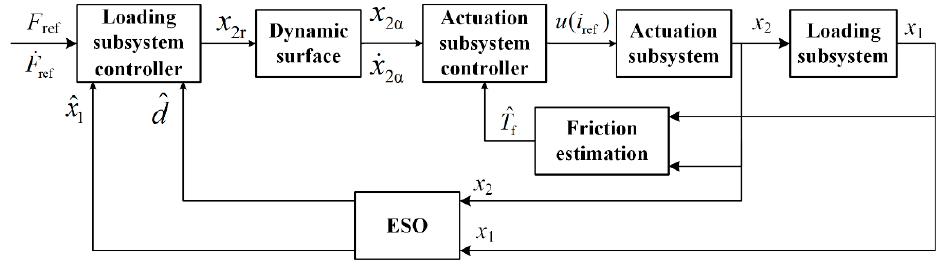
Figure 3. The architecture of the proposed observer-based adaptive backstepping controller.